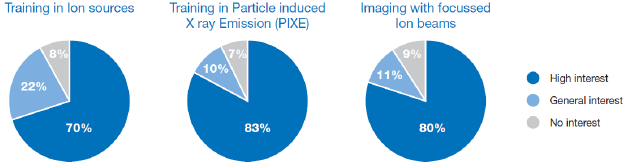
Fig. 8. Level of interest for applications of an Ion Beam Accelerator at IAEA Laboratories, according to the feasibility study conducted in 2018.